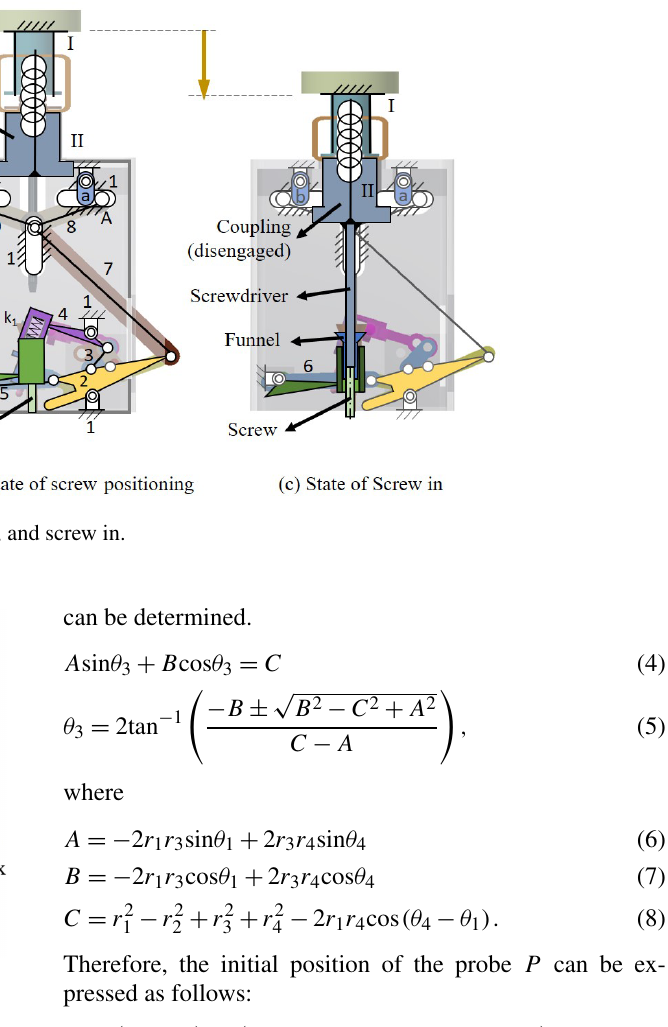
ment of the plunger and the holder with a screw. The extreme